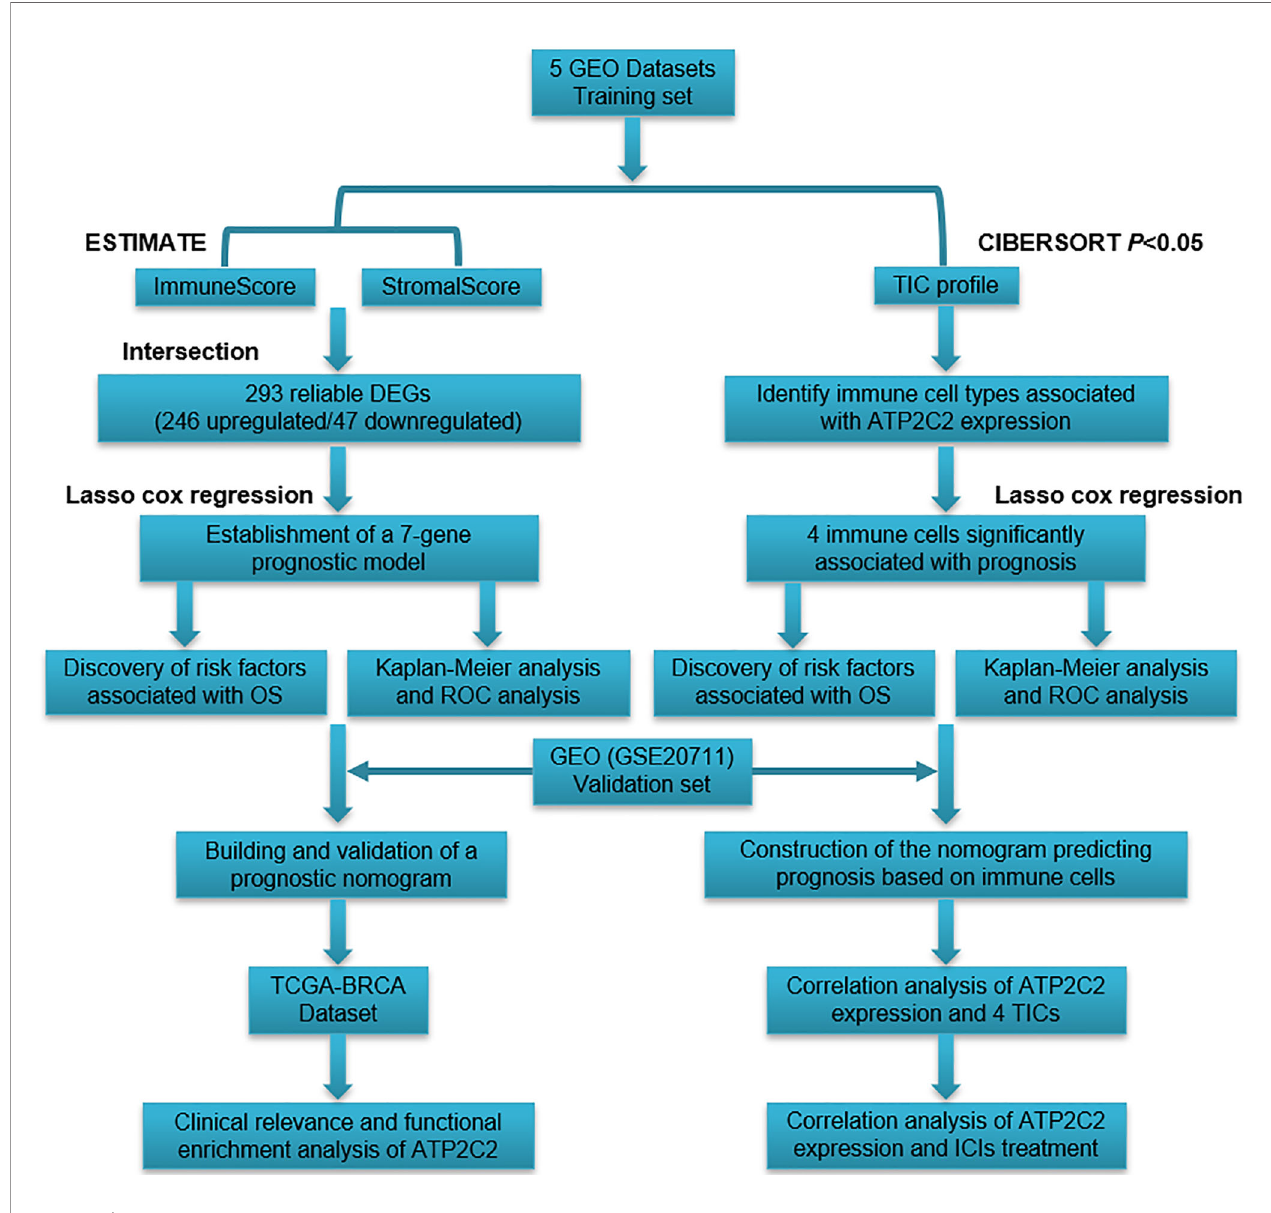
FIGURE 1 | Experimental technical